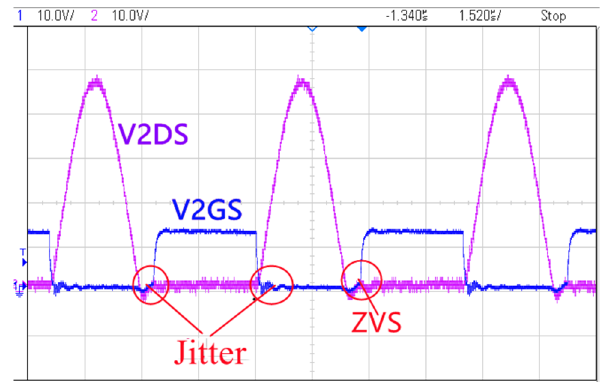
Figure 21. Traditional topological soft switch waveforms .